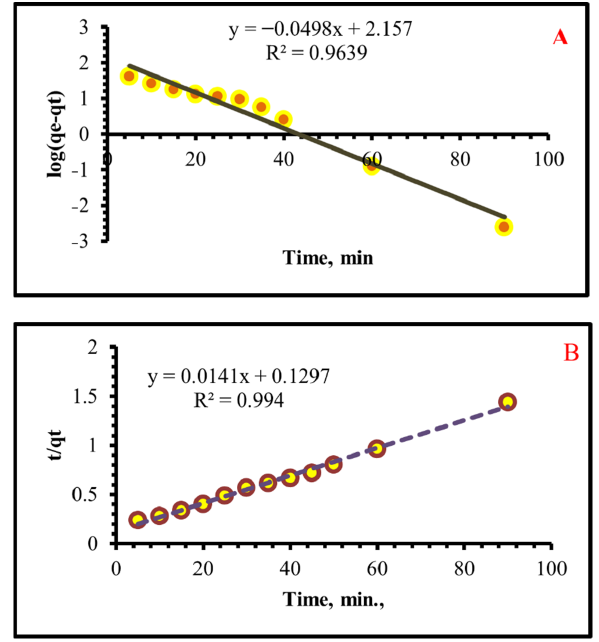
Table 2. Kinetic factors controlling Cr(VI) adsorption upon TIHP.